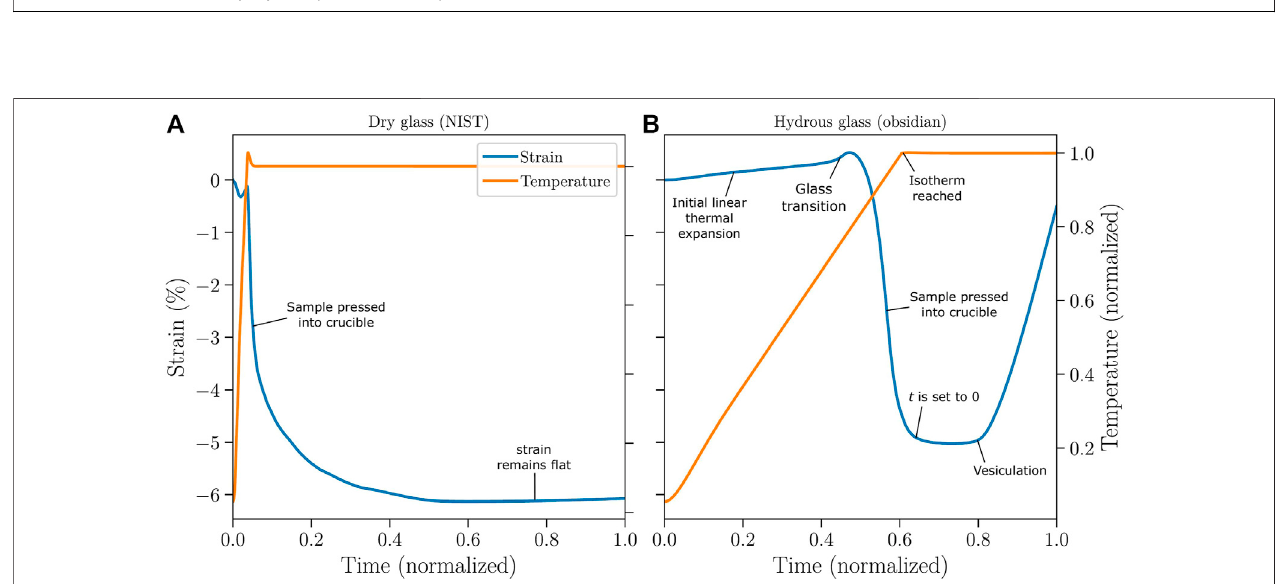
FIGURE2| Temperature-pressureconditionsofourexperiments. Thepredicted P-Tconditionsofsaturationforarhyolitecontaining0.11±0.01 wt%ofwaterare shown as a dashed line with a blue shaded region representing uncertainty, using the model from Liu et al. (2005). Above and left of this region, the sample is supersaturated inwater.Belowand rightofthisregion, thesampleisundersaturated.Thepressureduring staticexperiments is P 0 =177±8 kPaanddisplayed asared verticaldotted line(with red shaded regions representinguncertainty). The minimum and maximum pressures reached during oscillations, P min = 106± 1and P max =250±10 kParespectively,areshownasblackverticaldottedlines(withgrayshadedregionsrepresentinguncertainty).Thehorizontaldouble-headedarrowislocated at T = 965 ° C, where the majority of experiments were performed.